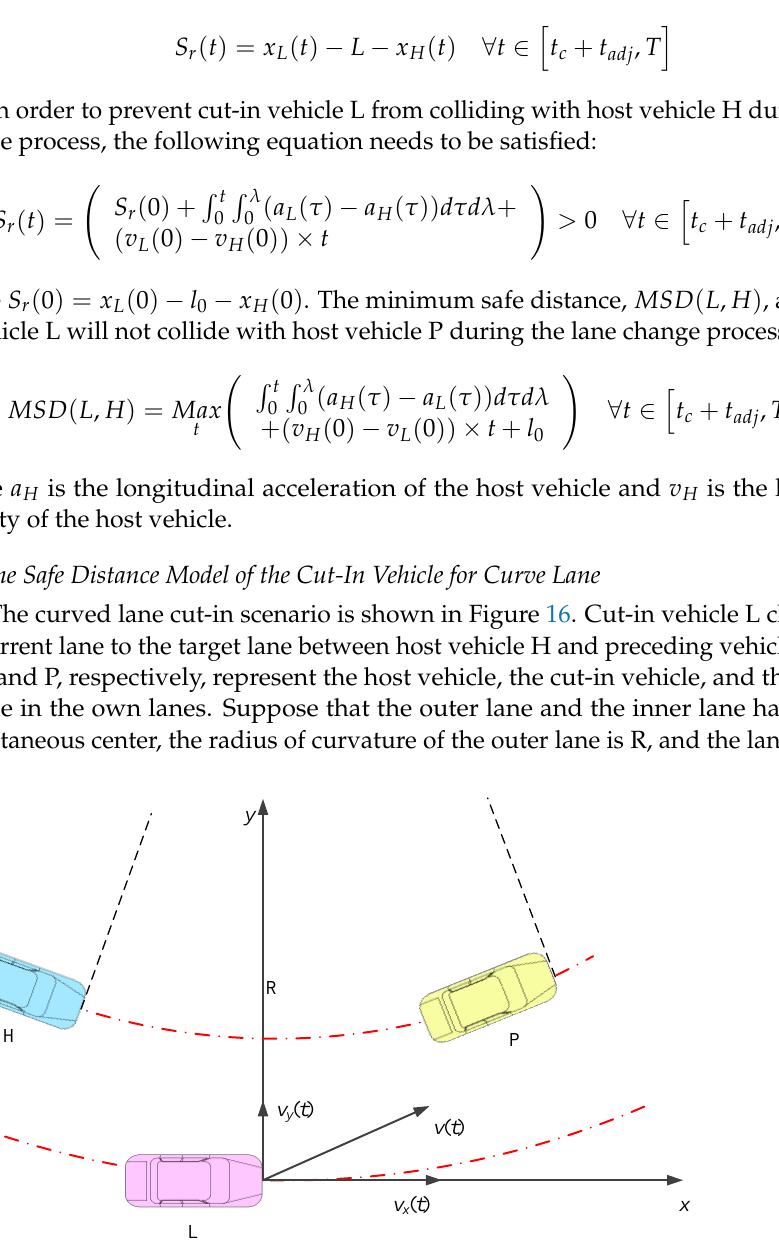
Figure 16. The position between the cut-in vehicle and the surrounding vehicles in a curved lane.